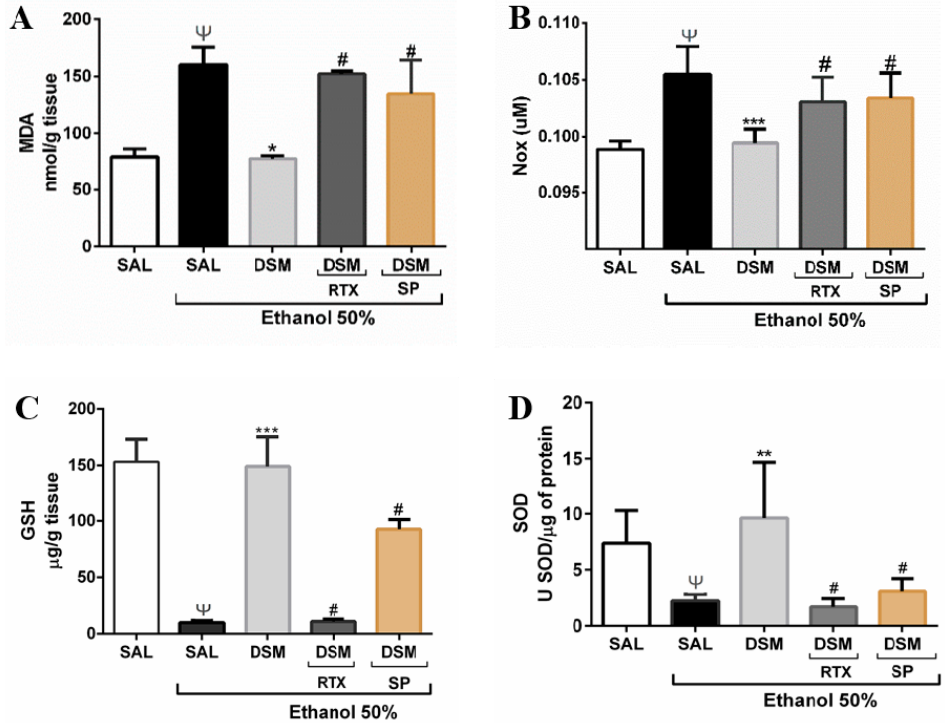
Figure 5. Effects of DSM supplementation on biomarkers of oxidative stress in mice with ethanol-induced gastric damage. Ethanol increased MDA ( A ) and NOx ( B ) levels in gastric tissue, but supplementation with DSM (10 8 CFU/g • bw/day for 3 days) significantly prevented this effect. Ethanol administration decreased the gastric glutathione (GSH) concentration ( C ) and superoxide dismutase (SOD) activity ( D ). This effect was reverted significantly when the animals were supplemented with DSM. However, administration of RTX with ethanol reversed the protective effects of DSM for all parameters evaluated. Coadministering SP with ethanol overcame the protective effects of DSM. Data shown are the mean ± SEM of at least 5 mice per group; Results were analyzed using one-way analysis of variance followed by a Newman–Keuls post hoc test. ( A ): Ψ p < 0.05 versus healthy group; * p < 0.01 versus injured group; # p < 0.001 versus DSM group; ( B ): Ψ p < 0.0001 versus healthy group; *** p < 0.01 versus injured group; # p < 0.001 versus DSM group; ( C ): Ψ p < 0.0001 versus healthy group; *** p < 0.0001 versus injured group; # p < 0.0001 and # p < 0.05 versus DSM group; ( D ): Ψ p < 0.05 versus healthy group; ** p < 0.001 versus injured group; # p < 0.001 versus DSM group.